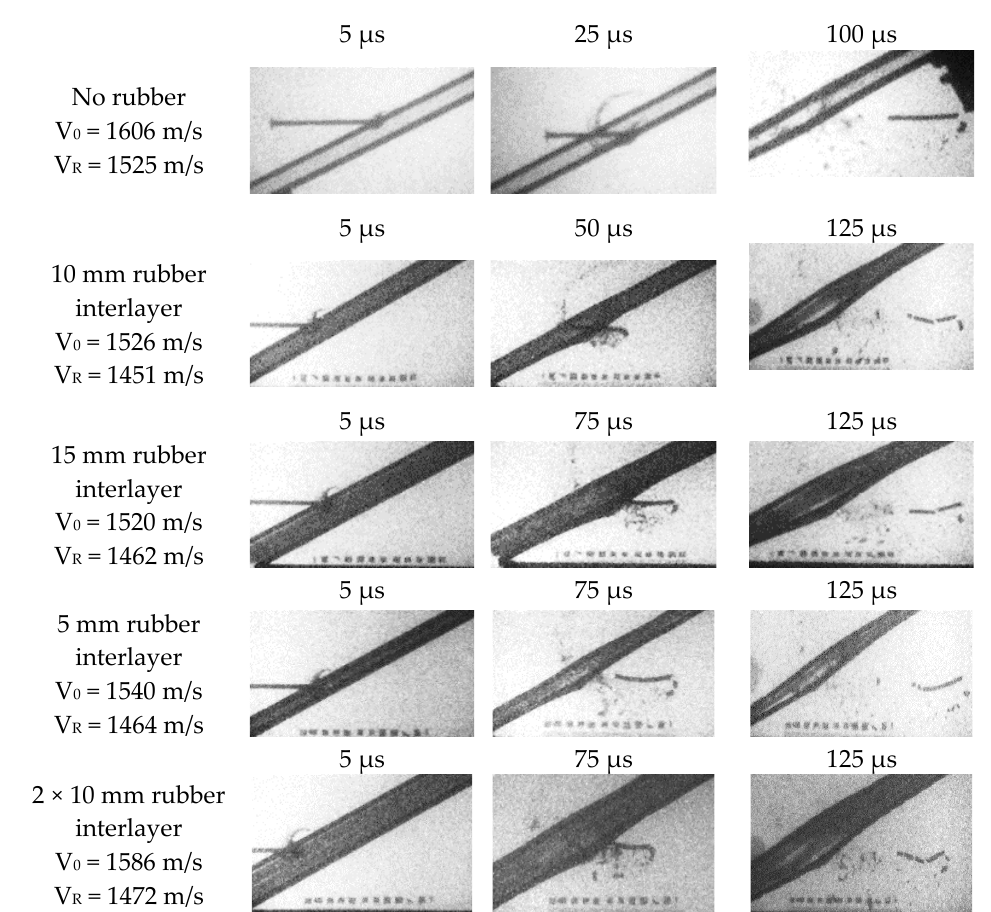
Figure 6. Ballistic shots registered on the flash X-ray images (V 0 — initial velocity, V R — residual velocity).